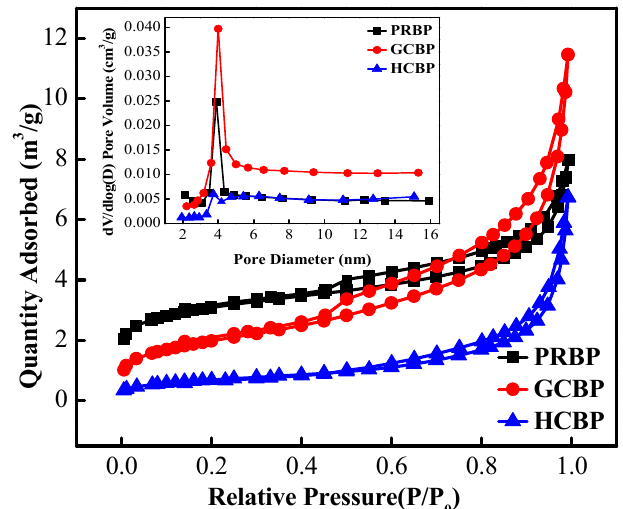
Figure 1. N 2 adsorption/desorption isotherms and corresponding BJH pore size distribution.